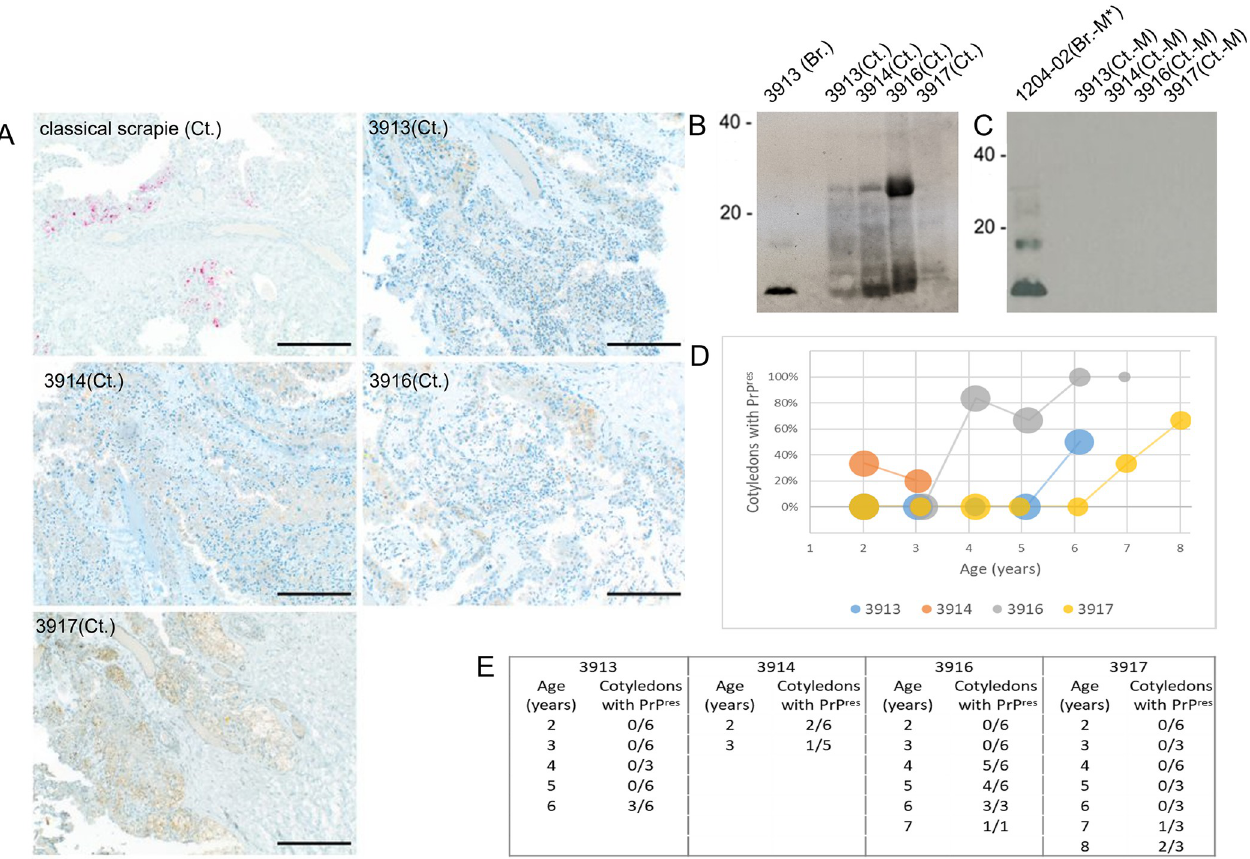
Fig 3. Accumulation of non-infective PrP res in the placentas of ARR/ARR ewes infected by atypical scrapie from a US ARR/ARR sheep. A) PrP Sc was not detected in cotyledons (Ct.) from infected ewes (3913, 3914, 3916, 3917) by immunohistochemical staining; note red staining in cotyledon from a sheep with classical scrapie shown for comparison. B) Anti-PrP western blot showing accumulation of PrP res in cotyledons from infected ewes. Brain homogenate (Br.) from ewe 3913 shown for comparison. C) Anti-PrP western blot showing lack of PrP res in brain homogenates from Tg338 mice inoculated with homogenates of cotyledons containing PrP res (Ct.–M); inocula were prepared from the same cotyledons shown in (B). Brain homogenate of passage 2 mouse (Br.–M � ) from original atypical scrapie donor shown for comparison. Western blots labeled with molecular weight markers of 20, 40 kDa. D,E) The proportion of cotyledons containing PrP res , detected via western blot, increased with the ages of the inoculated